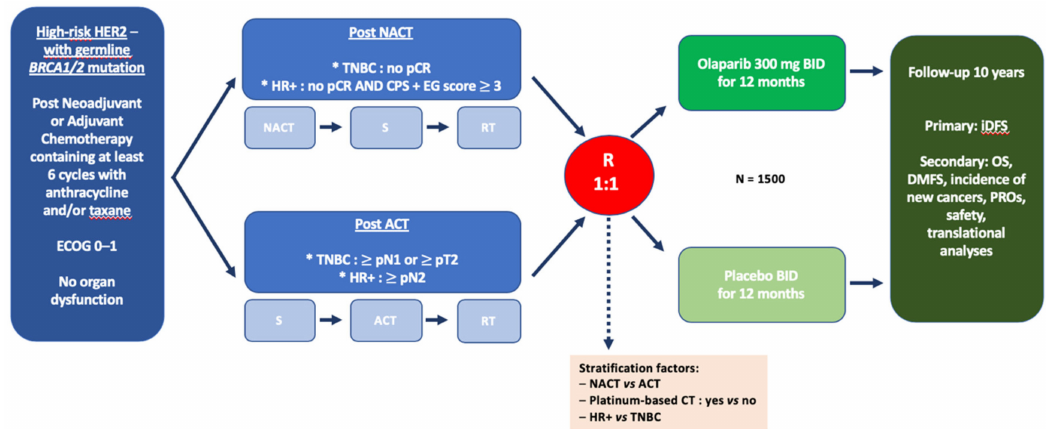
Figure 3. Design of the OlympiA adjuvant study. HER2—human epidermal growth factor receptor 2; TNBC—triple negative breast cancer; ECOG—Eastern Cooperative Oncology Group; HR—hormone receptor; germline BRCA1 / 2 mutation—germline breast cancer 1 or breast cancer 2